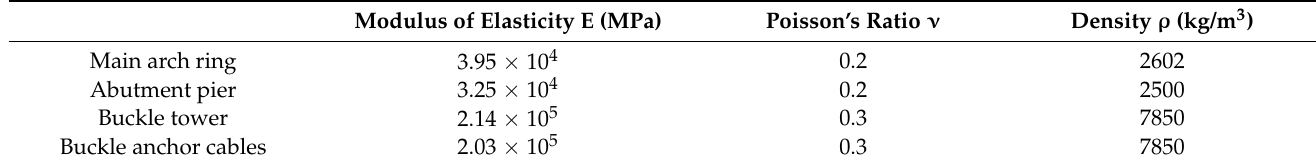
Table 5. Various material parameters.